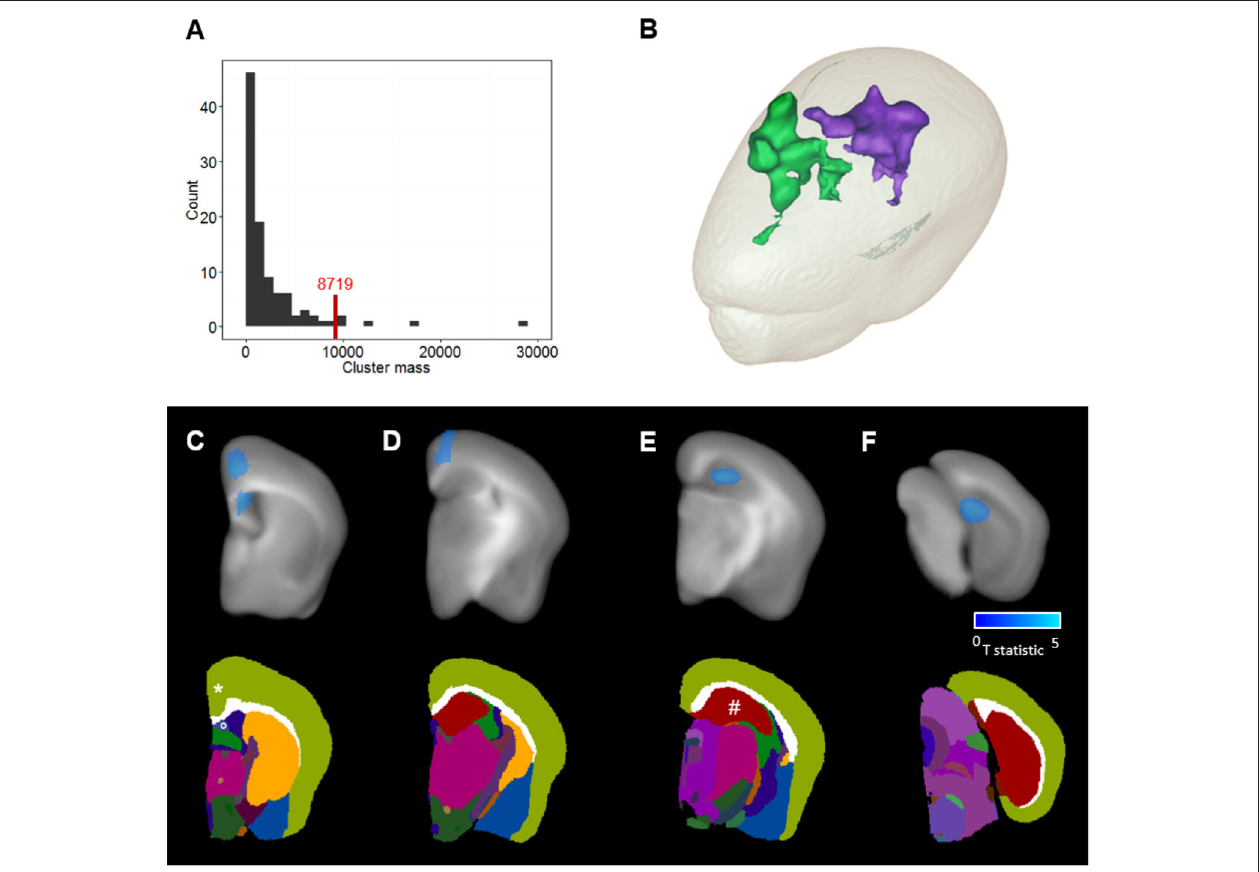
FIGURE 6 | Clusters detection and anatomical localization. (A) Permutation-based cluster mass distribution under the null-hypothesis. The red line corresponds to the significance threshold at a risk α = 0.05. (B) 3D mesh representation of the two clusters where the A β load is reduced in APP Swe , Ind -Cre-ADAM30 mice compared to APP Swe , Ind -ADAM30. Green corresponds to the cortical cluster and purple corresponds to the hippocampal cluster. (C–F) Top: T statistic values within the clusters are shown in blue and overlaid with the anatomical template at selected coronal levels of the brain. Bottom: the MICe brain atlas at the same coronal levels. Clusters are localized in (C) the retrosplenial area of the cortex (*), the lateral septal nucleus ( ◦ ), (D) the cingulate area of the cortex and (E,F) the dentate gyrus of the hippocampal region ( #